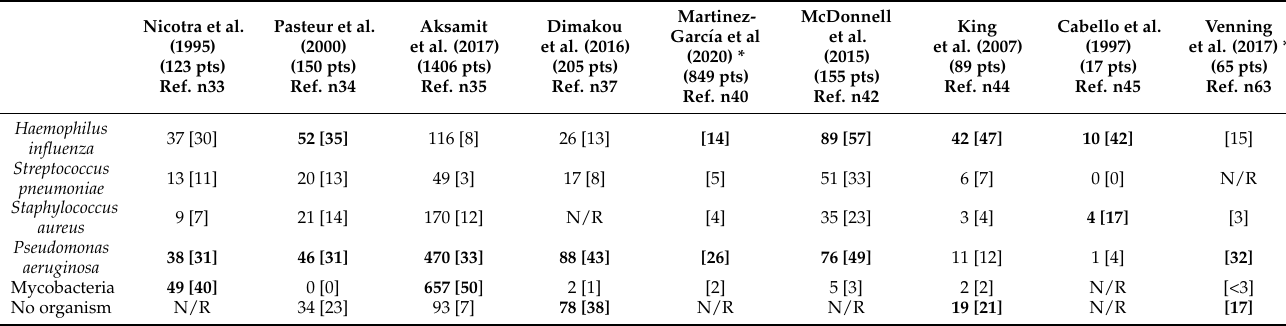
Table 1. Bacteriology of